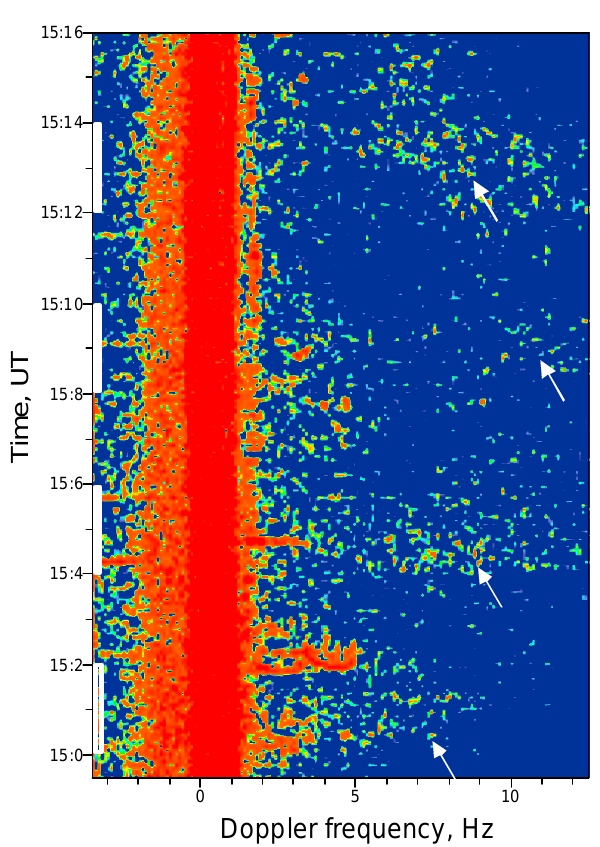
Fig. 3. Dynamic Doppler spectra of HF diagnostic signals on the London-Tromsø-St. Petersburg path at an operational fre- quency of 17640kHz on 13 October 2006 from 14:59 to 15:16UT. The vertical white bars on the time axis indicate when the EIS- CAT/HEATING facility was transmitting. The EISCAT/HEATING facility was operating at 4040kHz with O-mode polarisation, in cy- cles of 2min on/2min off; the heater beam was tilted along the magnetic field-aligned direction (magnetic zenith).